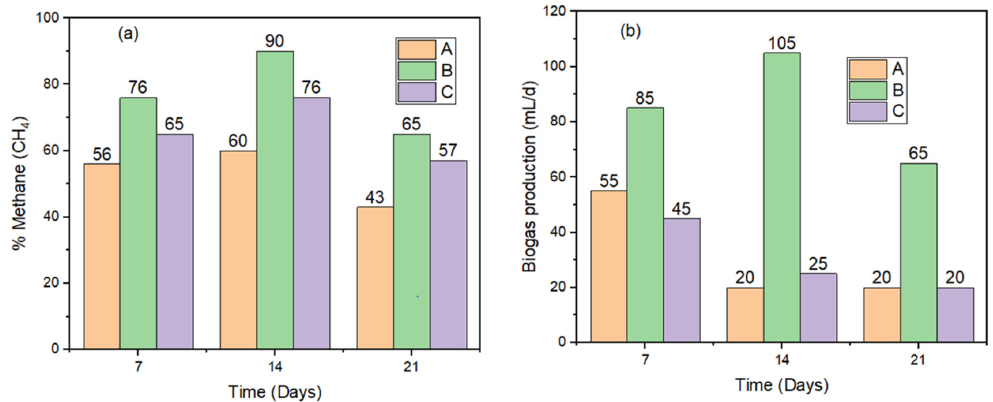
Figure 7. Biochemical methane potential (BMP) weekly monitoring ( a ) methane content (%), and ( b ) biogas production (mL/d); B—Ms (green) > A—Alum (brown) > C—Control (violet).